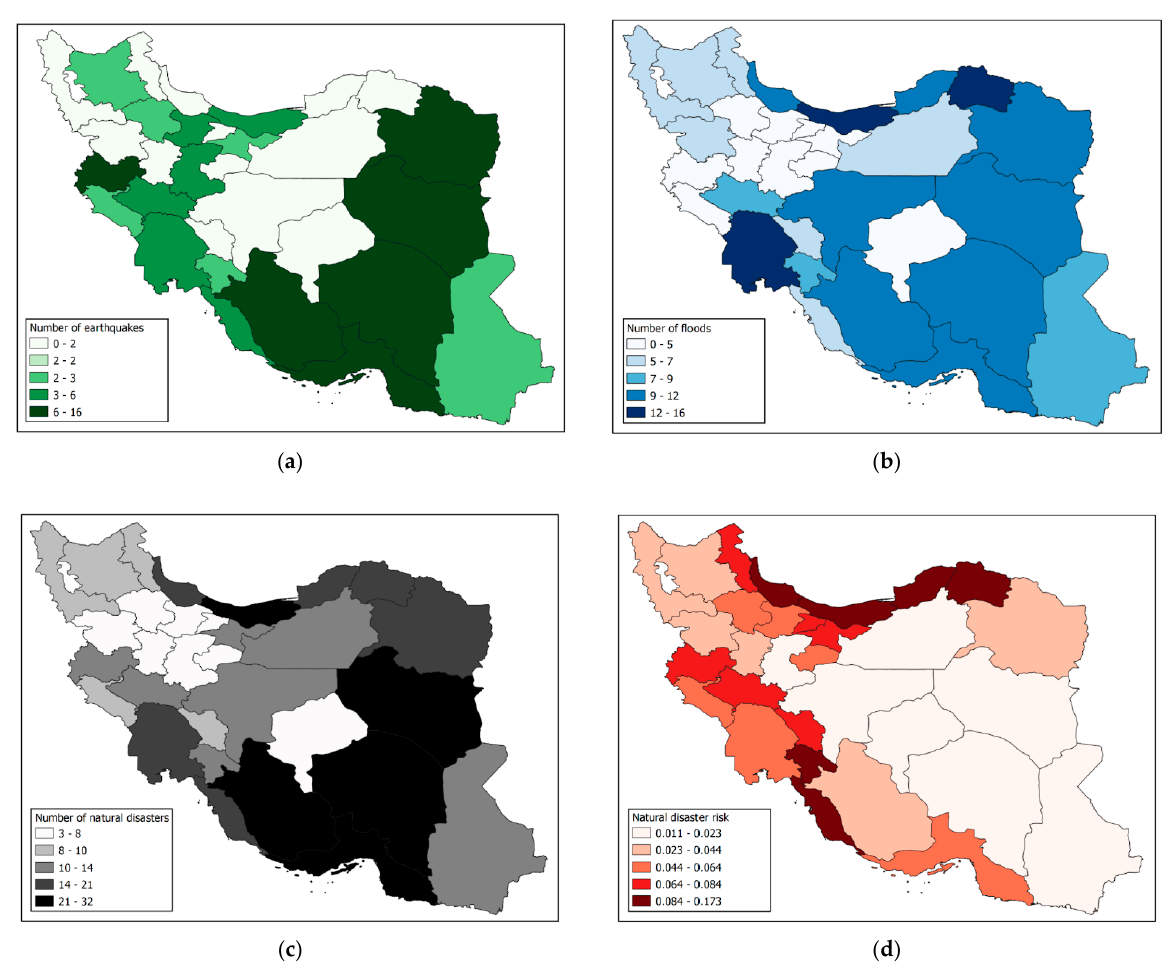
Figure 1. Spatial distribution of the occurrence of natural disasters in Iran: ( a ) number of disastrous earthquakes per Iranian province, 1950–2019; ( b ) number of disastrous floods per Iranian province, 1950–2019; ( c ) number of natural disasters per Iranian province, 1950–2019; ( d ) natural disasters per year per 10,000 km 2 (based on the years 1950–2019). Source: author’s illustration with data from International Disaster Database (EM-DAT